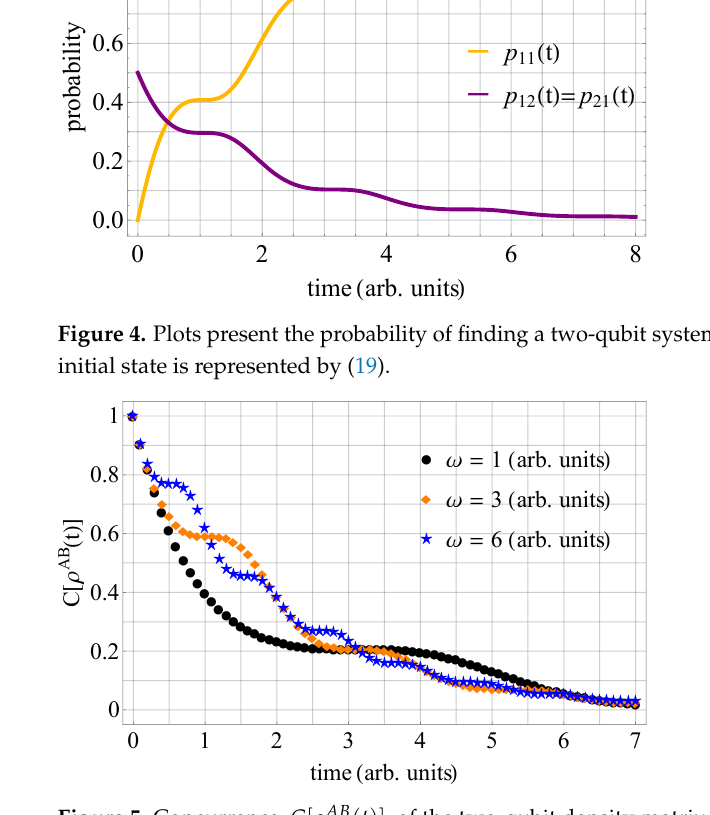
Figure 5. Concurrence, C [ ρ AB ( t )] , of the two-qubit density matrix with the initial state (19) for three values of ω